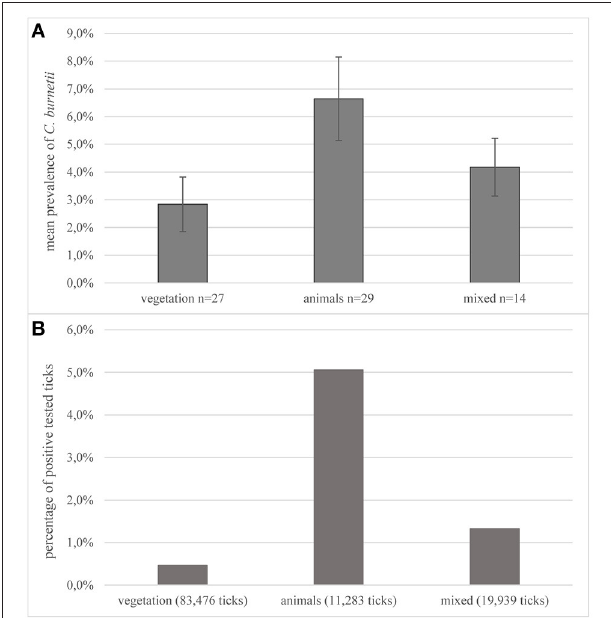
FIGURE 4 | Collection methods. (A) Average prevalence of C. burnetii in studies on ticks depending on the collection method. Error bars show average confidence intervals. n = number of studies; (B) percentage of positively tested ticks of the total number of tested ticks in all studies, depending on the collection methods. Number in parentheses = total number of sampled ticks with this